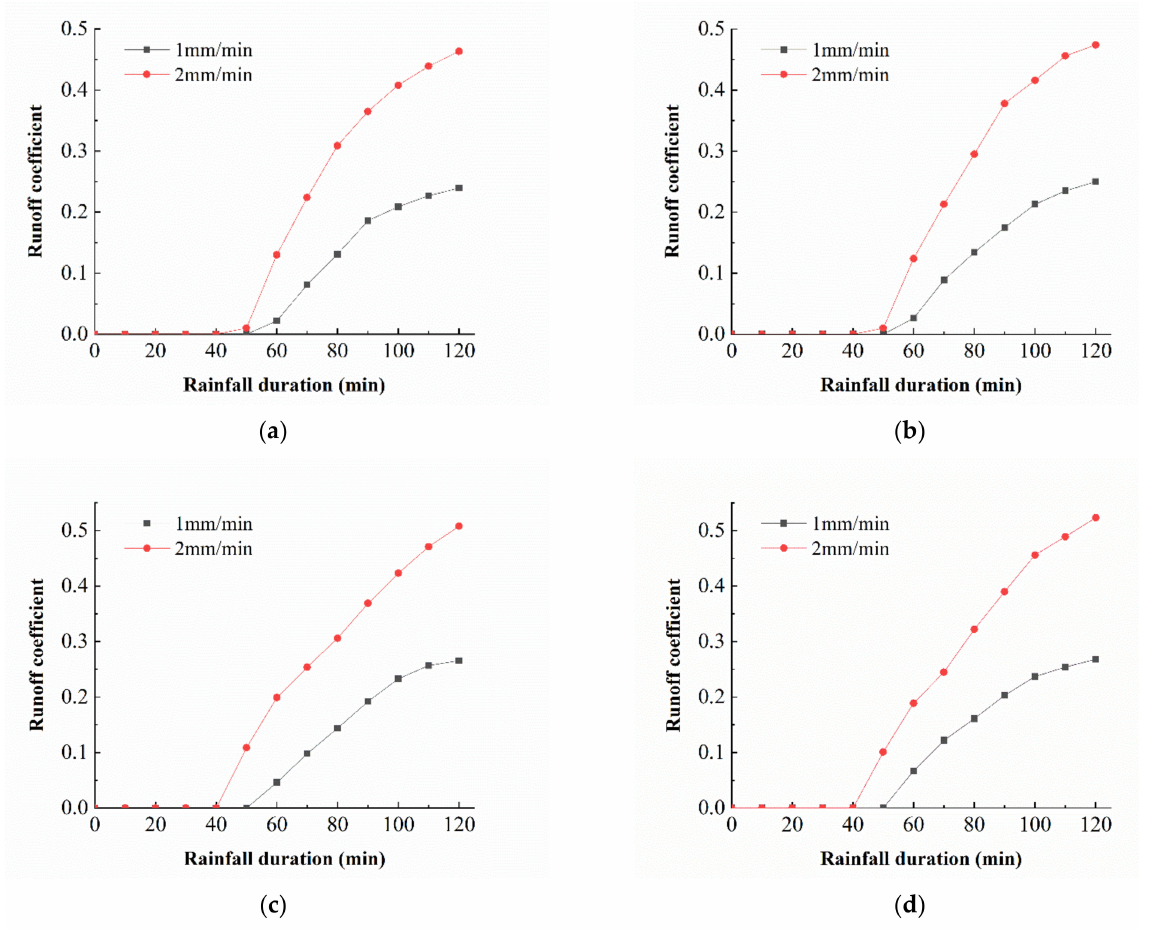
Figure 4. Runoff coefficient of each permeable pavement under different rainfall intensities: ( a ) type I; ( b ) type II; ( c ) type III; and ( d ) type